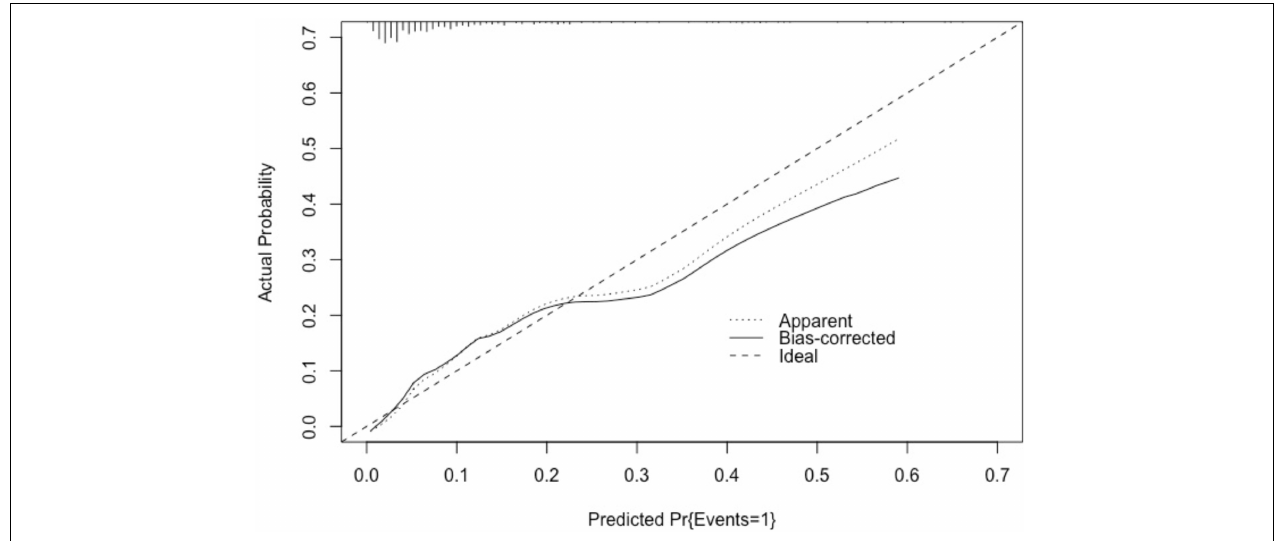
FIGURE 5 | Calibration curve of nomogram model in the validation cohort. As demonstrated in the calibration curve of the nomogram model in the validation cohort, the predicted value was basically consistent with the measured value. “Basically consistent” means that the actual solid line and the ideal dashed line were basically parallel, indicating that the nomogram model of this study has a good